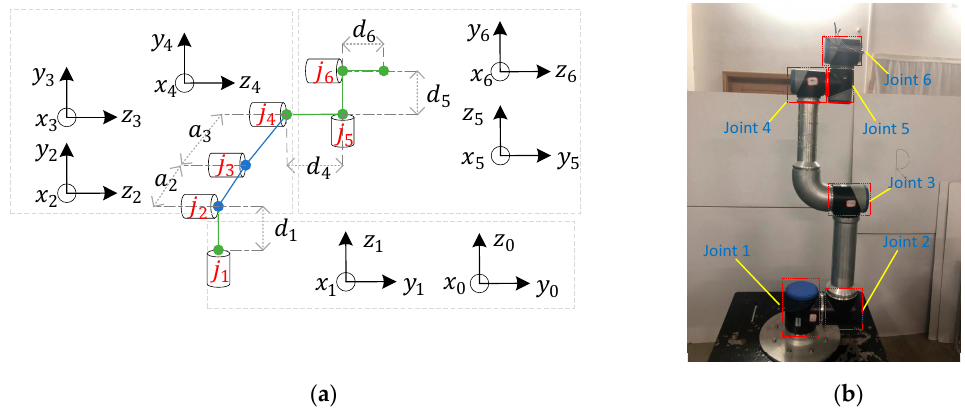
Figure 1. ( a ) Schematic for the KingKong parameters: 𝑑 (cid:3038) is the linkage length of the 𝑘 th link and 𝑎 (cid:3038) is the linkage torsion of the 𝑘 th link. 𝑗 (cid:3038) is the 𝑘 th joint. ( b ) Visualization of the KingKong model.